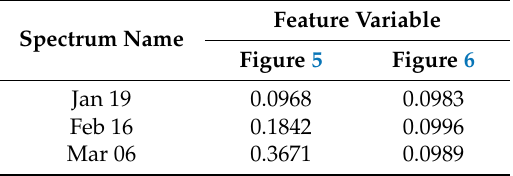
Table 5. Feature variables of spectrum shown in Figures 5 and